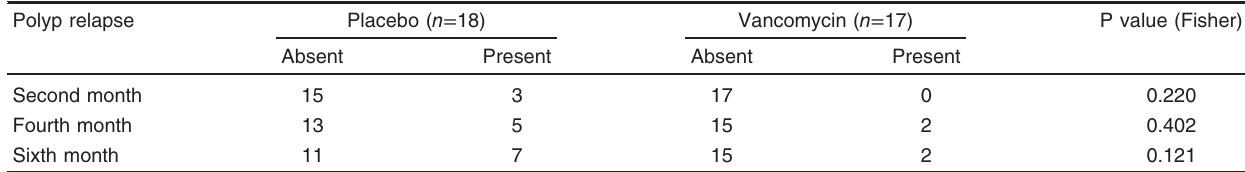
Table 2 The recurrence rate of postoperative sinonasal polyposis in the vancomycin and placebo